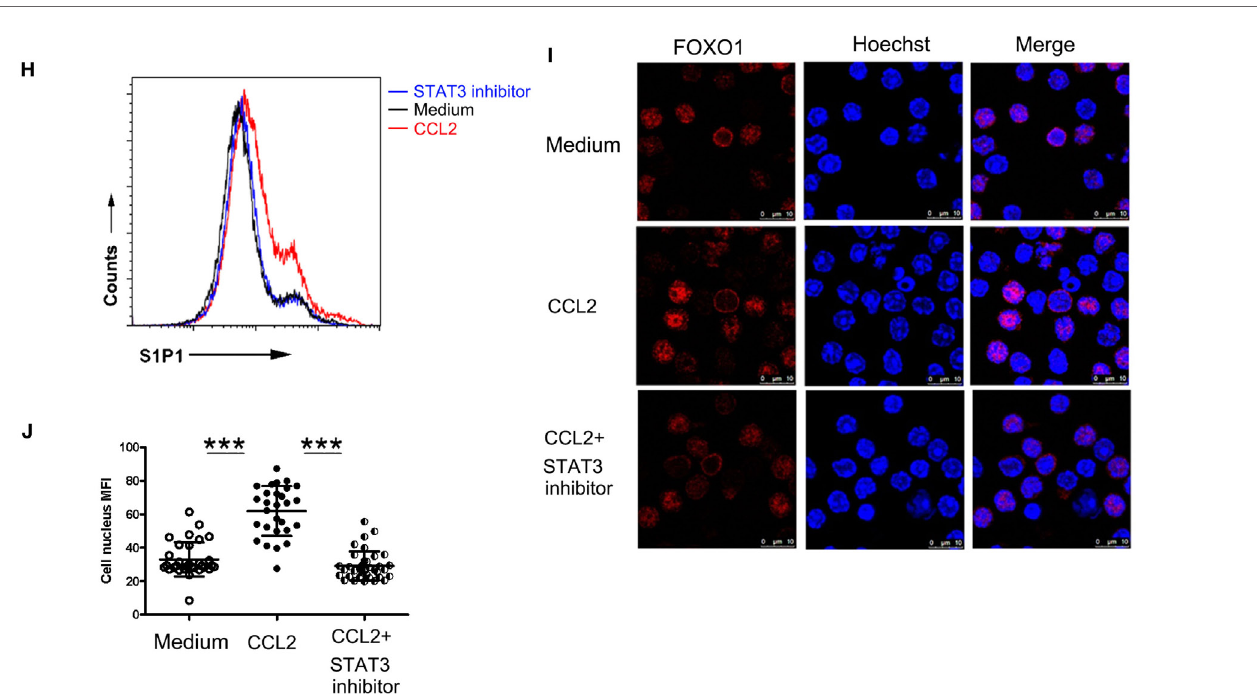
FigUre 5 | Activation of the FoxO1–KLF2–S1P1 axis by CCR2 signaling through Stat3. (a) Surface expression of S1P1 in the CD69 + Qa-2 − (SP1 + SP2), CD69 − Qa-2 − (SP3), and CD69 − Qa-2 + (SP4) subsets of CD4 SP thymocytes from WT and KO mice. The experiments were repeated three times with six mice for each group. Representative dot plots are shown. (B) Percentage of S1P1 + cells are presented as mean ± SD . (c) Foxo1, Klf2, and S1pr1 mRNA expression in WT and KO CD4 SP thymocytes as determined by qPCR. The experiments were repeated three times with triplicates. Data are present as mean ± SEM. (D) CD69 − Qa-2 + SP4 thymocytes from WT and KO mice were stimulated with CCL2 in the presence or absence of STAT3 inhibitor Stattic. Foxo1, Klf2, and S1pr1 mRNA expression was detected by qPCR. The experiments were repeated three times with triplicates. Data are present as mean ± SEM. (e) Following stimulation with CCL2, WT SP4 thymocytes were examined for surface expression of S1P1. Representative histograms are shown out of three independent experiments. (F,g) Levels of phosphorylated Stat3 were examined by Western blotting (F) or intracellular staining (g) in SP4 thymocytes after stimulation with CCL2. Western blotting was performed at 30 min after stimulation. The experiments were repeated three times with similar results. (h–J) SP4 thymocytes were stimulated with CCL2 in the presence or absence of STAT3 inhibitor Stattic. Surface expression of S1P1 was assayed by flow cytometry (h) . Subcellular localization of FoxO1 was revealed by immunofluorescent staining (i) and nucleus Foxo1 was quantified by mean fluorescent intensity (MFI) (J) . Data are presented as mean ± SD. Two independent experiments were performed with similar results. * p < 0.05, ** p < 0.01, *** p < 0.001. Abbreviations: ns, no significance; S1P1, sphingosine-1-phosphate receptor 1; SP, single-positive; WT, wild-type; KO, knockout; KLF2, Kruppel-like factor 2; FoxO1, forkhead box